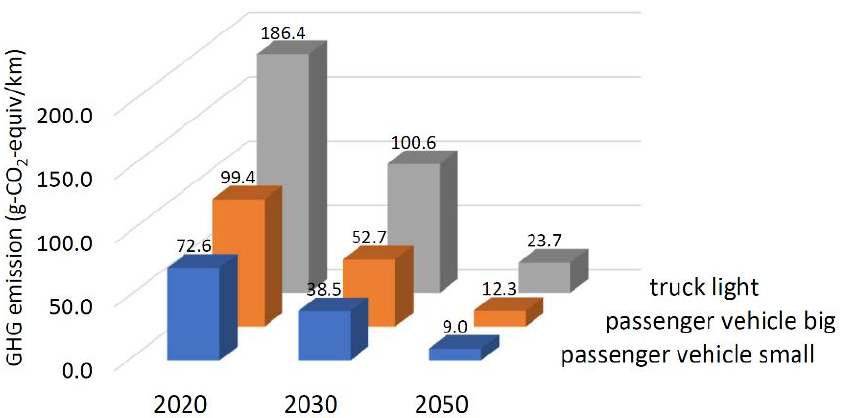
Figure 14. GHG emissions of large passenger vehicles in 2050 as a function of drive technology (transition season, hilly terrain, WLTP triple-mixed drive cycle, and tank to wheel).